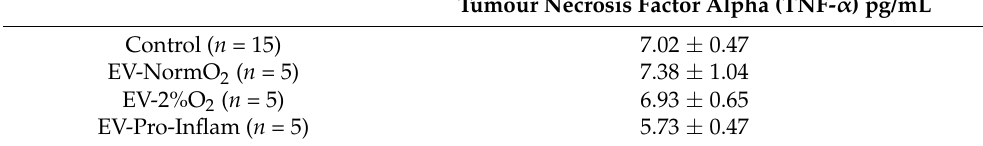
Table 1. Circulating TNF- α detected in serum of EV treated mice. ELISA for the presence of TNF- α in serum (pg/mL) of treated mice demonstrate no significant differences between control ( n = 15) and test conditions ( p > 0.05, n =